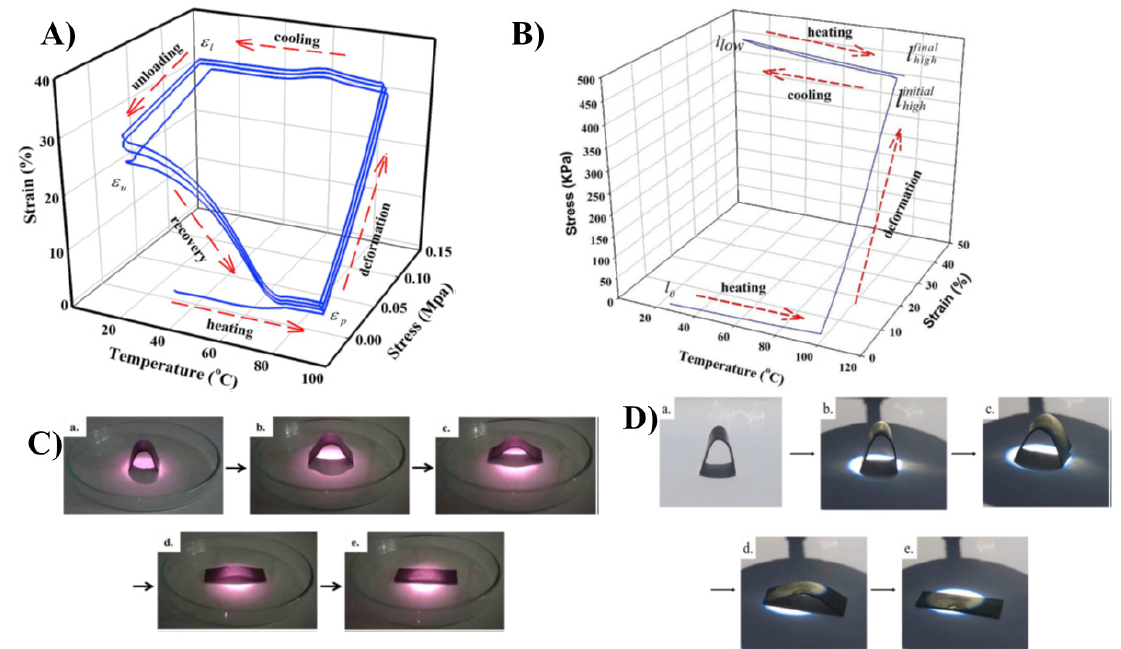
Figure 4. ( A ) One-way shape memory cycle for the natural rubber/paraffin wax 6:4 blend. ( B ) Two-way shape memory cycle for the NR. ( C ). Near-infrared laser-induced shape memory effects of NR/PW 6:4–0.5 CNT [( a )original sample, ( b ) irradiated for 15 s, ( c ) 30 s, ( d ) 90 s, and ( e ) 120 s]. ( D )Sunlight-induced shape memory effects of NR/PW 6:4–0.5 CNT [ ( a ) original sample, ( b ) irradiated for 30 s, ( c ) 60 s, ( d ) 90 s, and ( e ) for 120 s] (Reproduced with permission from [67], Elsevier. 2019).